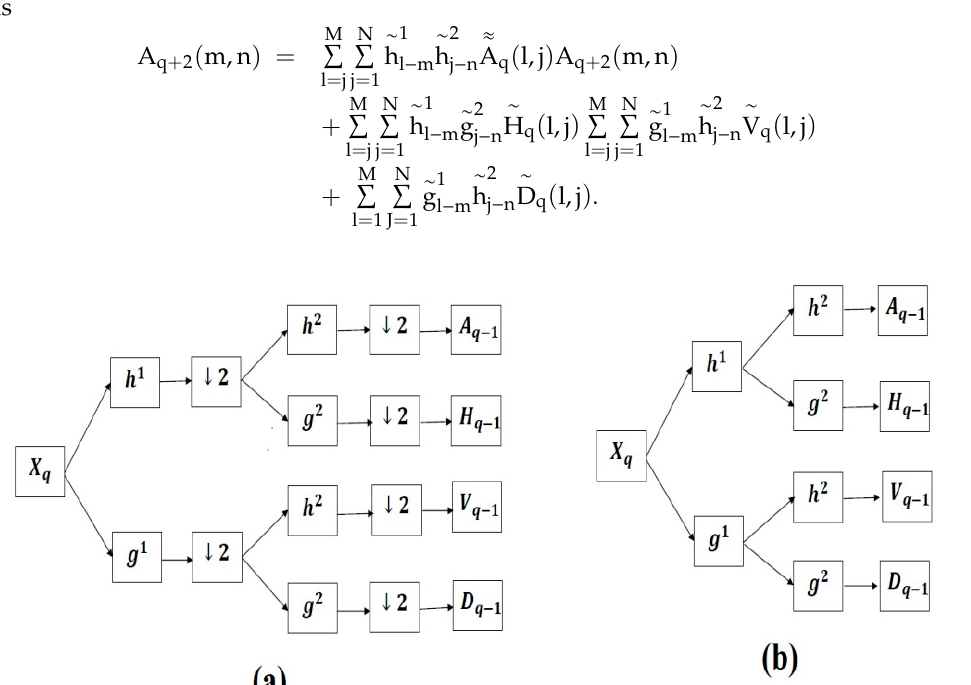
Figure 1. ( a ) Discrete wavelet transform (DWT) decomposition and ( b ) stationary wavelet transform (SWT) decomposition.